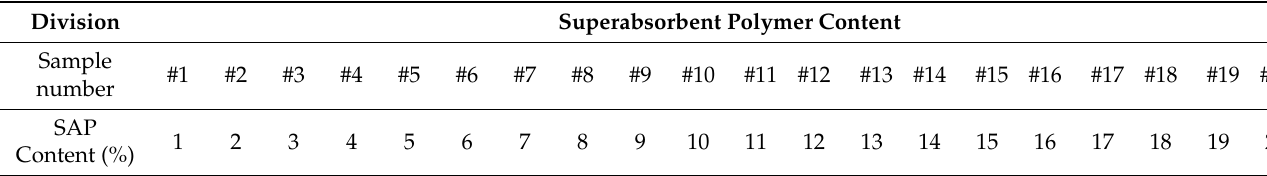
Table 3. The superabsorbent polymer mixing conditions.